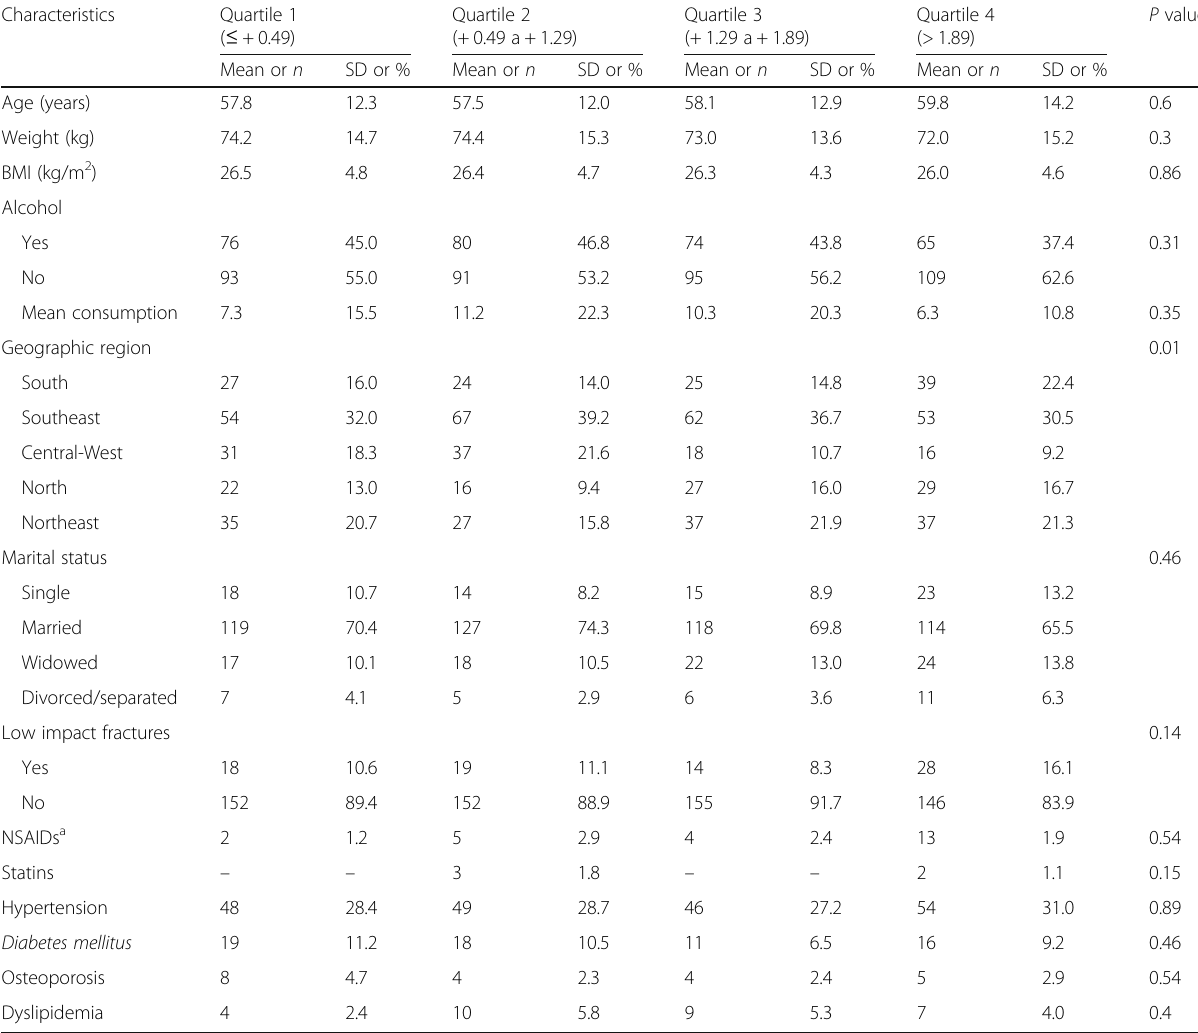
Table 4 Characteristics of the participants according to DII quartile for Brazilian men